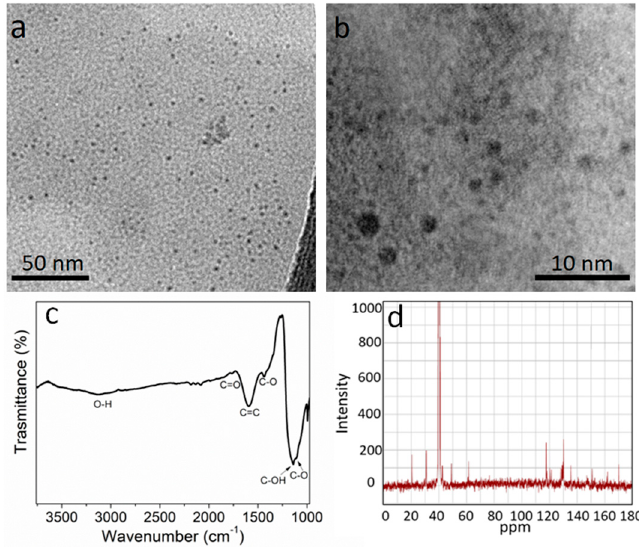
Figure 1. ( a ) Low-magnification and ( b ) high-magnification TEM image UFQDs. ( c ) FT-IR and ( d ) 13 C NMR spectra of UFQDs.